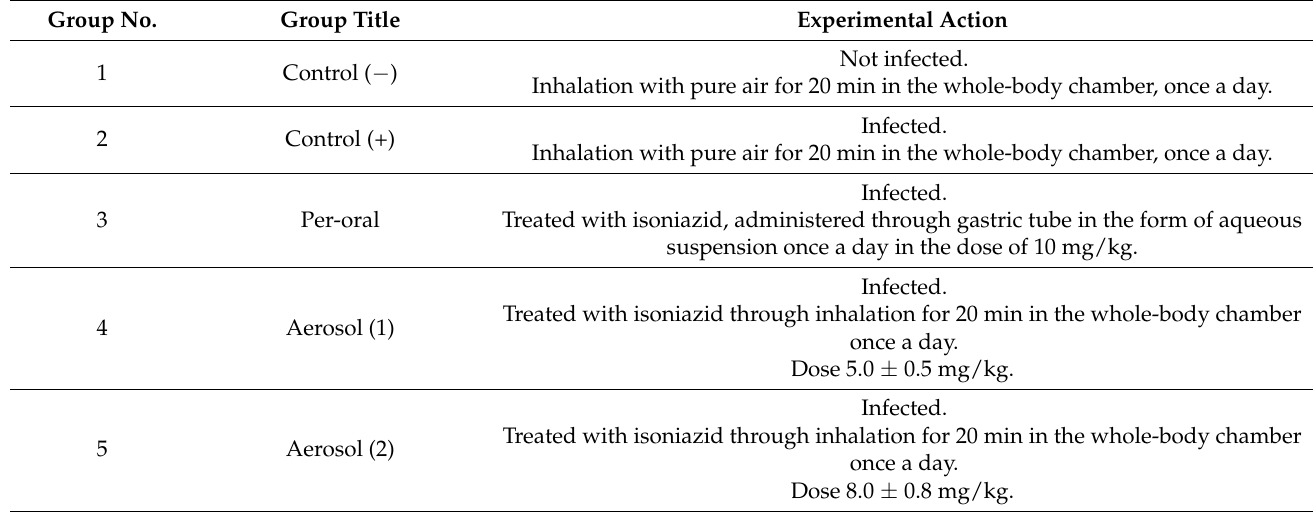
Table 1. Experimental groups of laboratory mice.